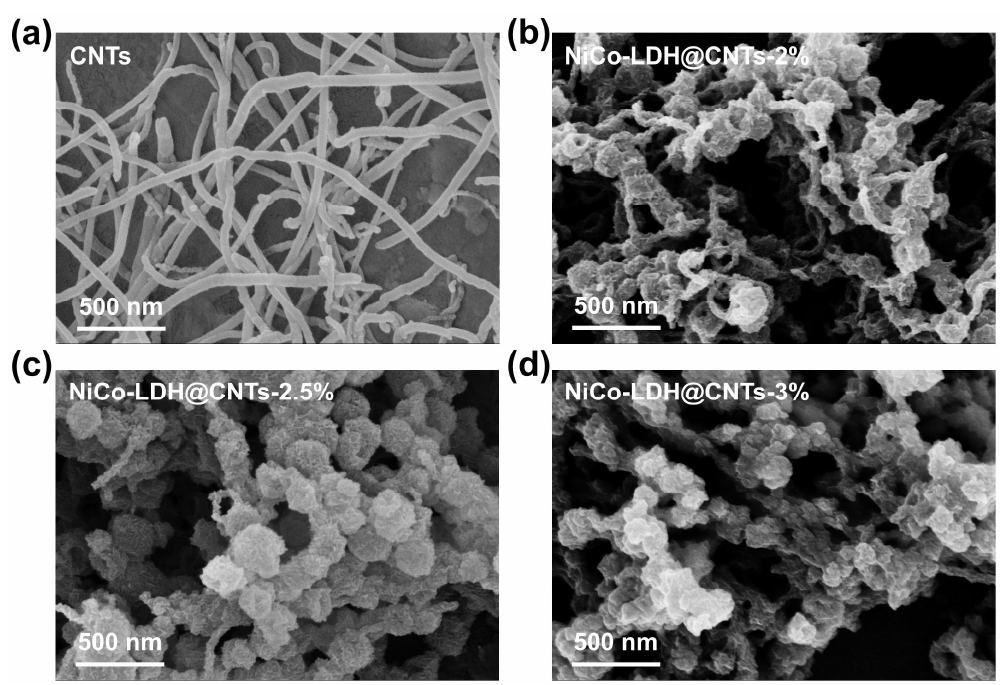
Figure 2. SEM images of ( a ) CNTs, ( b ) NiCo-LDH@CNTs-2%, ( c ) NiCo-LDH@CNTs-2.5%, and ( d ) NiCo-LDH@CNTs-3%.